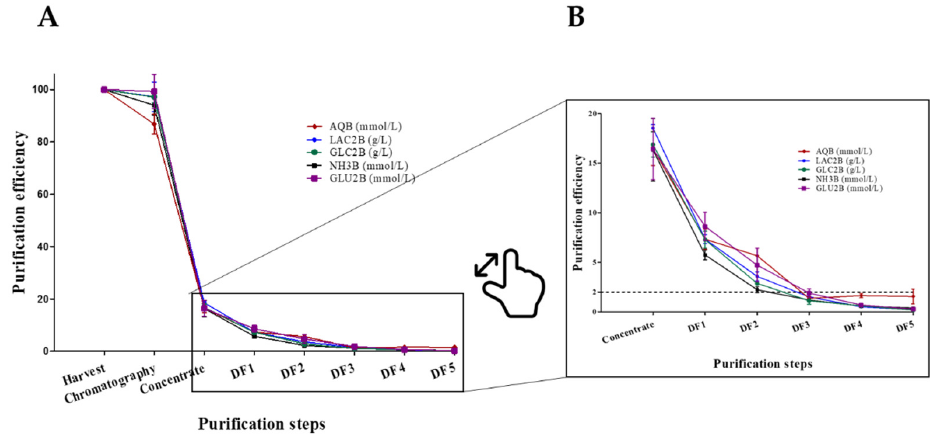
Figure 2. Metabolite and nutrient purification efficiencies for three DSPs. Each metabolite/nutrient was measured in each step of the DSP. The initial concentration was set as 100% and all the others were normalized accordingly. The results from three processes were averaged and the SD was calculated ( A ). Zoom in to purification efficiencies of the diafiltration steps ( B ). The dashed line represents 2% of the initial concentration.